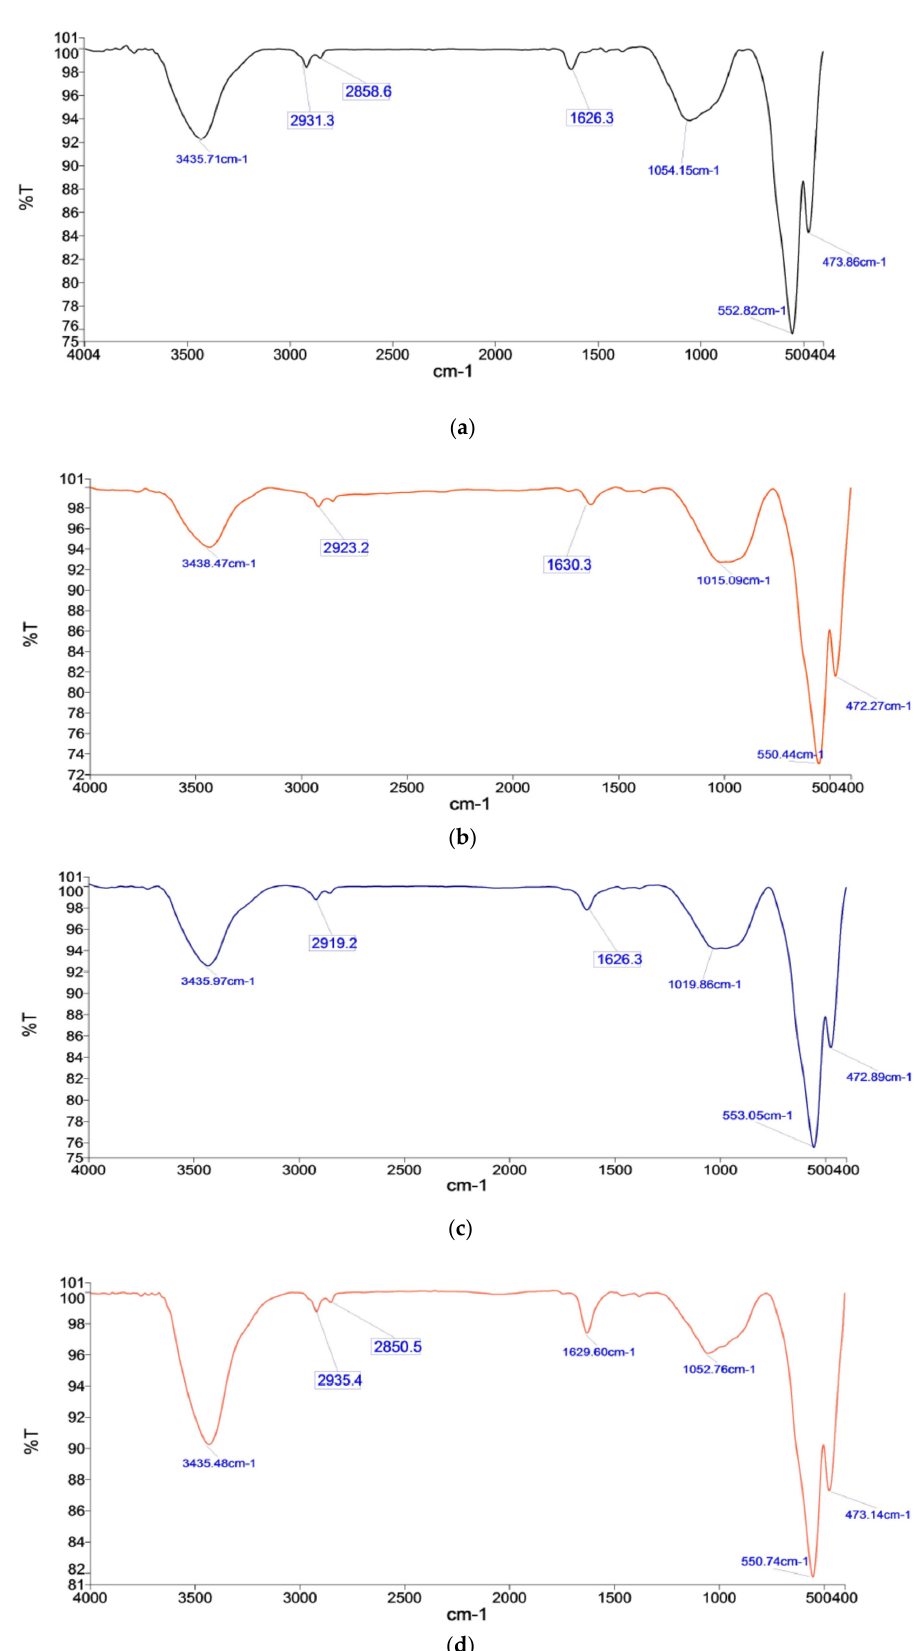
Figure 15. FTIR spectrographs of pellets ( a ) K1A, ( b ) K2B, ( c ) K3A, and ( d ) K4C.